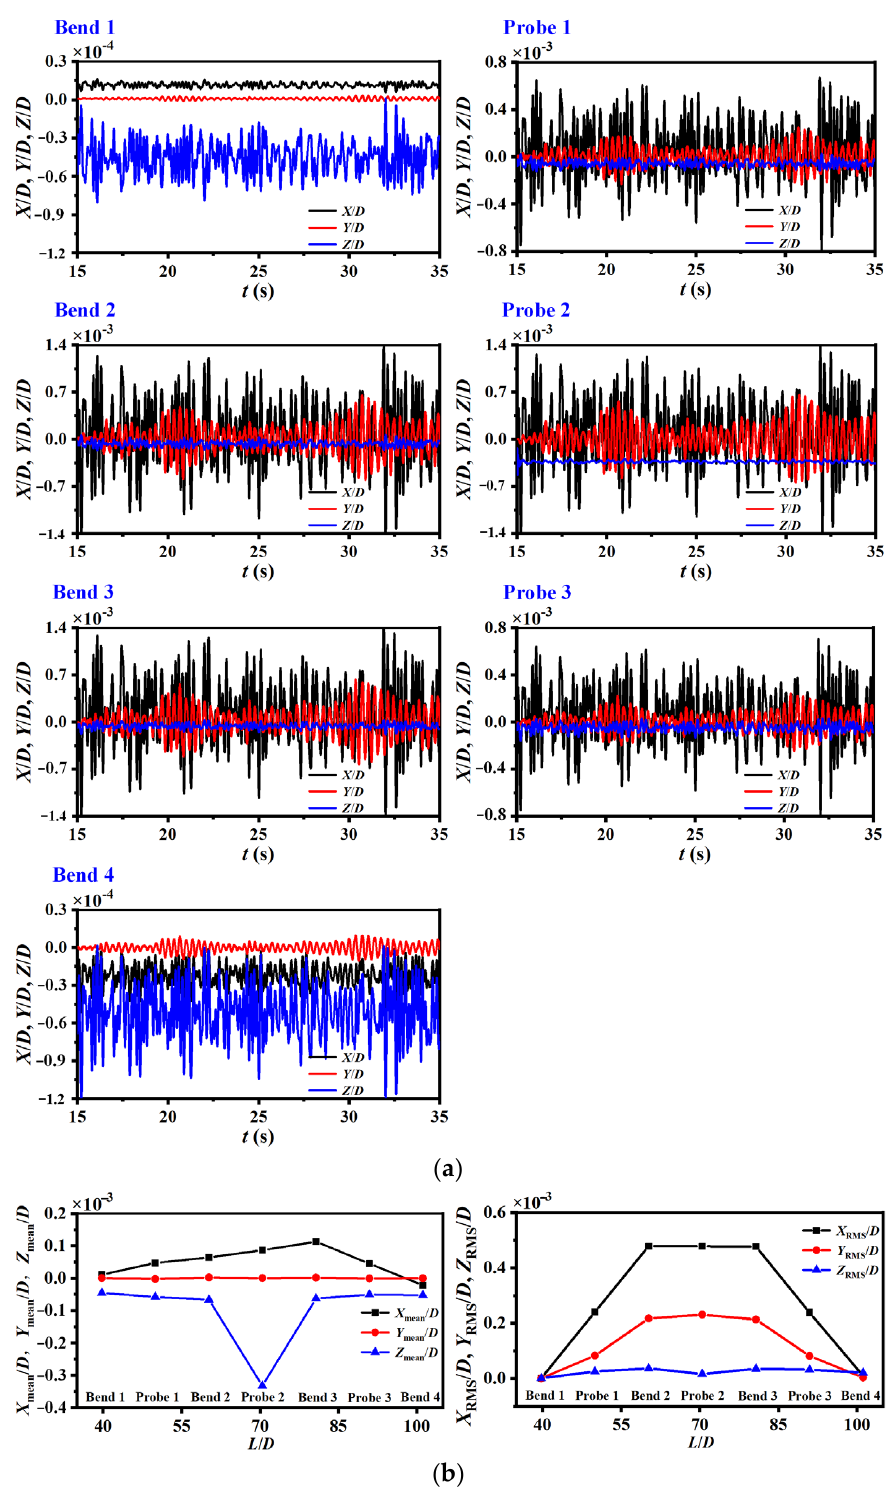
= 6 kg/s and Q L = 144 kg/s: ( a ) time histories of m-in m − in